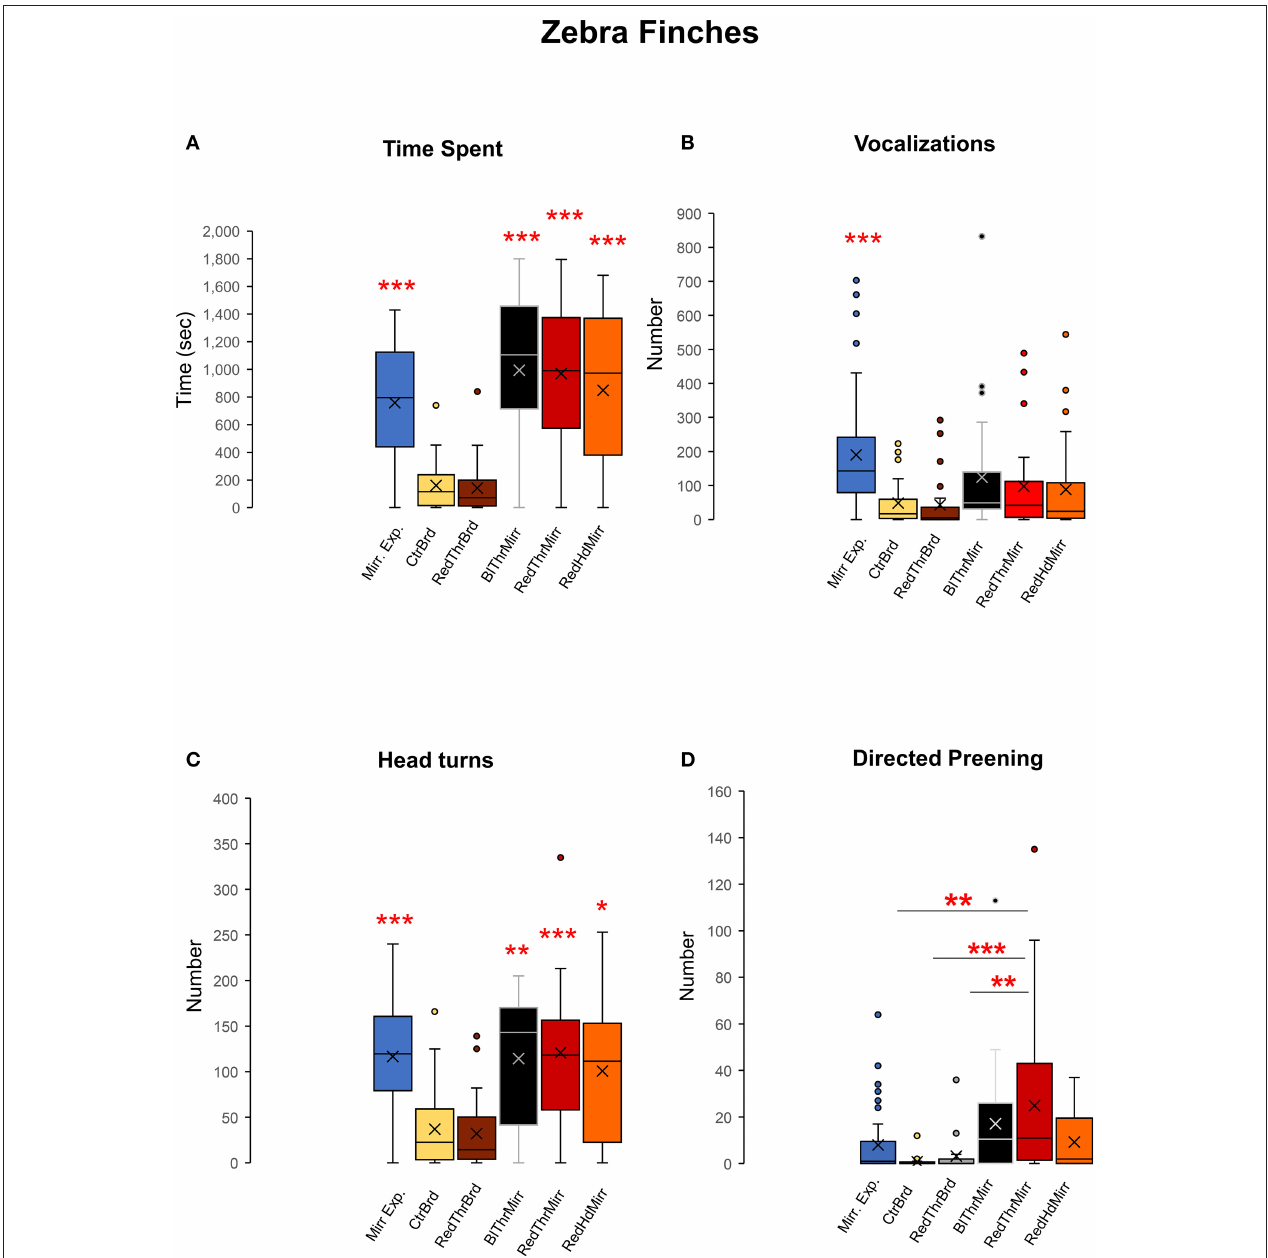
FIGURE 4 | Attention paid to the reflection, social responses, contingency, and preening behaviors of zebra finches during the mark test. (A) Zebra finches ( n = 6) spent significantly higher amounts of time facing the mirror during both mirror exposure and mirror test trials compared to facing a board of similar dimensions (control), suggesting that there was an increase in attention paid toward their reflections. (B) Zebra finches vocalized (sang and called) more toward their reflections during the mirror exposure period compared with other test conditions ( post-hoc Tukey test ***, P < 0.001). (C) There was a significant increase in head turning (a contingency behavior) by all zebra finches used in our study while facing the mirror ( post-hoc Tukey test *; P < 0.05, **; P < 0.01, ***; P < 0.001). (D) There was a significant increase in directed preening on the neck in the RedThrMirr condition compared to that in the CtrBrd, RedThrBrd, and mirror exposure period ( post-hoc Tukey test; P < 0.01; **; P < 0.001***).